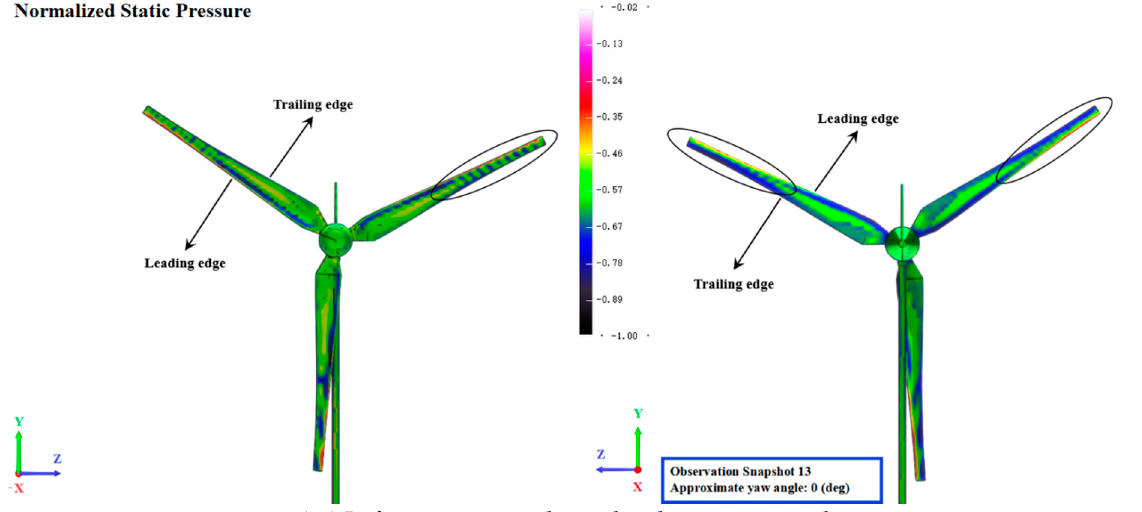
Figure 13. Transient static pressure characteristics on blade surfaces from snapshot 1 to snapshot 13.